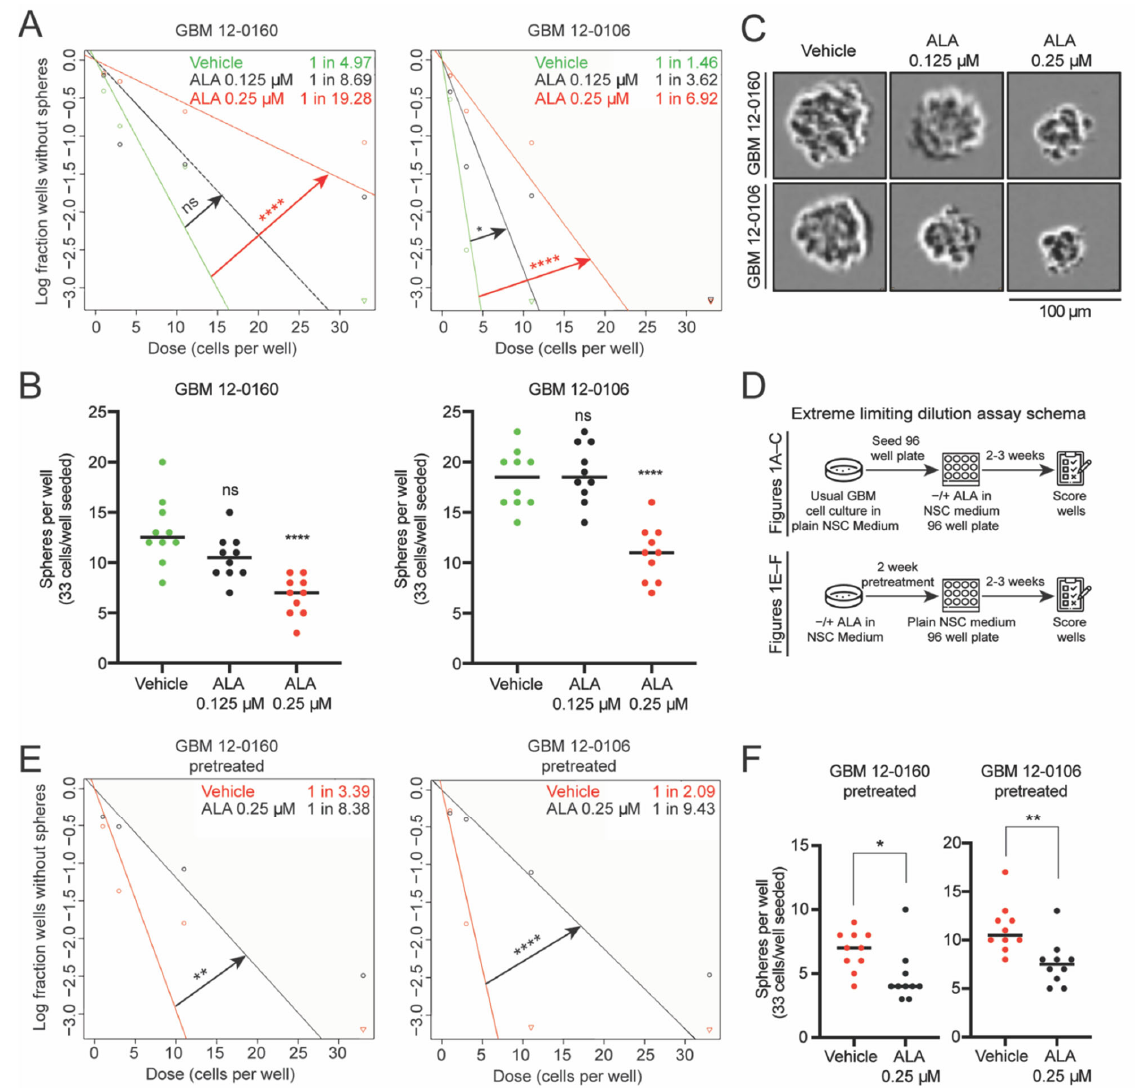
Figure 1. Inhibition of de novo purine synthesis using L ‐ Alanosine (ALA) decreases stem cell frequency and sphere ‐ forming capacity of MTAP ‐ deficient glioblastoma (GBM) cells. ( A ) Extreme limiting dilution assays (ELDAs) show ALA treatment decreases stem cell frequency in two MTAP ‐ deficient patient ‐ derived GBM cell lines. Stem cell frequency (1 in n) for each condition shown on plot. 33, 11, 3, 1 cells seeded per well, n = 12 replicates per condition. ( B ) ALA treatment decreases the number of spheres formed per well in ELDA. 33 cells seeded per well, n = 10 replicates per condition. ( C ) Representative images of tumor spheres derived from GBM 12 ‐ 0160 and GBM 12 ‐ 0106. Scale bar, 100 μ m. ( D ) Schema depicting design of ELDAs. Assays shown in ( A – C ) done with concurrent ALA treatment in 96 well plates; assays shown in ( E , F ) done with 2 weeks ALA pretreatment followed by seeding cells in neural stem cell (NSC) medium without ALA in 96 well plates. ( E ) Extreme limiting dilution assays (ELDAs) show 2 ‐ week pretreatment with ALA decreases stem cell frequency in GBM cells. Stem cell frequency (1 in n ) for each condition shown on plot. 33, 11, 3, 1 cells seeded per well, n = 12 replicates per condition. ( F ) 2 ‐ week pretreatment with ALA decreases the number of spheres formed per well in ELDA. 33 cells seeded per well, n = 10 replicates per condition. Data shown are mean +/ − SEM. Data analyzed using ELDA Chi ‐ square test ( A and E ), One ‐ Way ANOVA followed by multiple t ‐ tests ( B , F ); ns: not significant, * p < 0.05, ** p < 0.01, **** p < 0.0001.